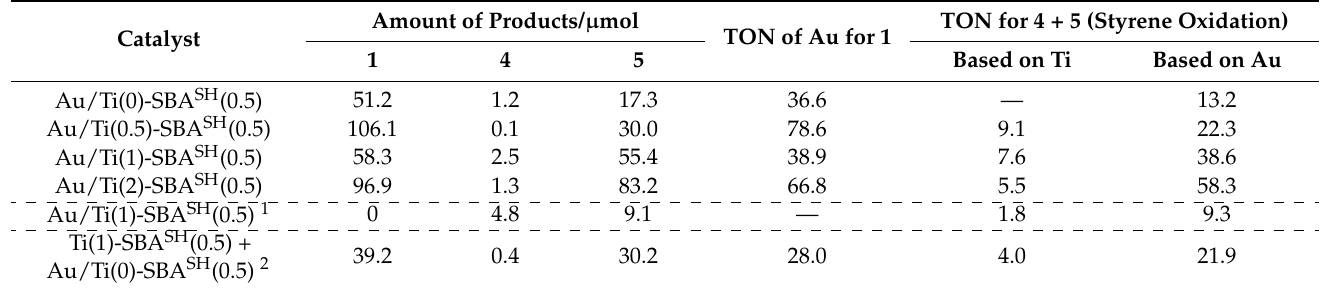
TON for 4 + 5 (Styrene Oxidation) TON of Au for 1 TON of Au for 1 Based on Ti Based on Au